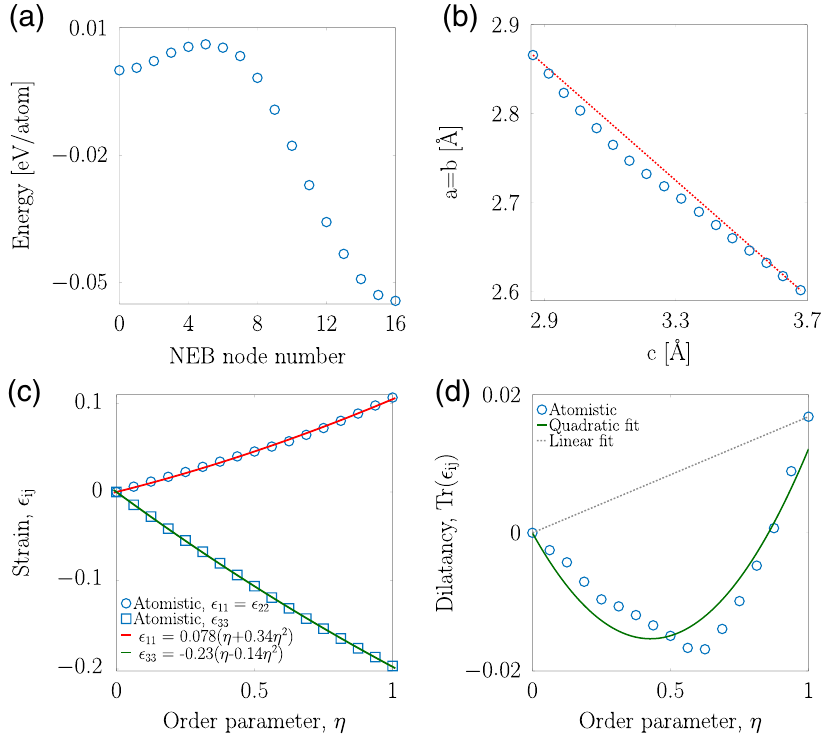
Fig. 1 Atomistic calculation of a free energy and b lattice parameters, and the corresponding c transformation strain components and d volume change along the Bain path in iron γ → α